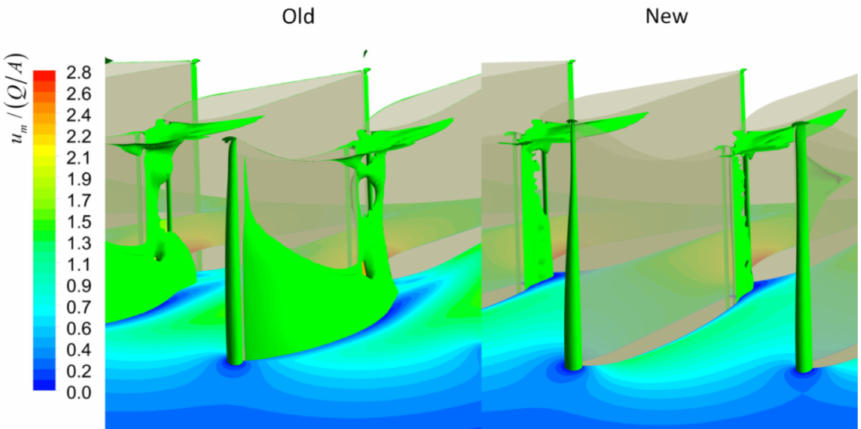
Figure 15. Flow velocity at the tandem cascade horizontal plane functions of the inlet area of the spiral case and the turbine discharge and u m = 0 isosurface in case 2 hydraulic